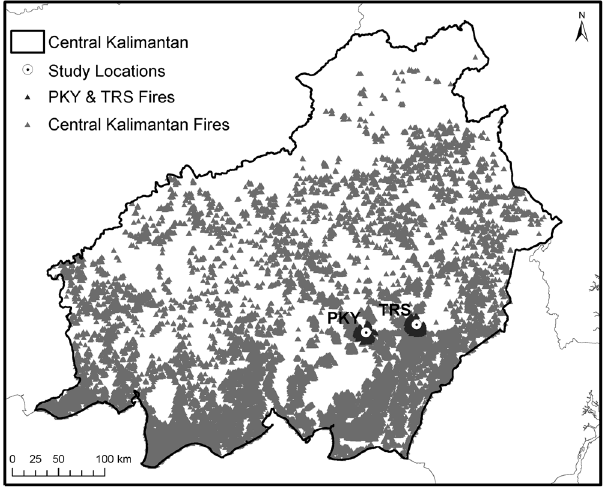
Figure 1. Map depicting 2015 fire hotspots (grey triangles) across Central Kalimantan detected by satellite (MODIS Active Fire Detections data set), and those within 10 km of Tuanan (TRS) and Palangkaraya (PKY) study locations (black triangles). Map created using ESRI ® ArcMap TM 9.3 http://www.esri.com/software/